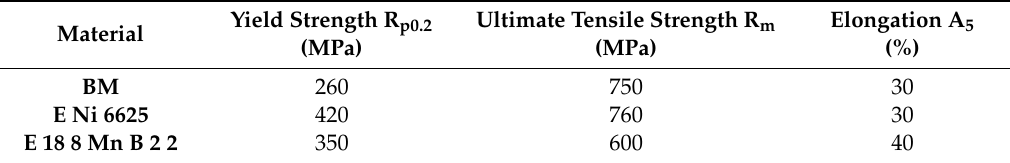
Table 2. Mechanical properties of used materials (average values) provided by producer *. Material Yield Strength R p0.2